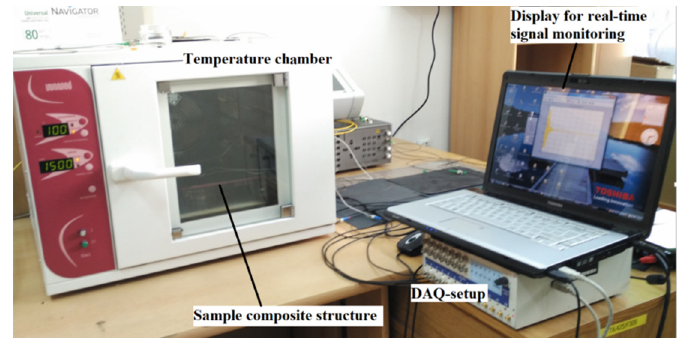
Figure 1. Experimental setup for the temperature-dependent analysis of debond effects on guided waves in the adhesively-bonded carbon-fibre composite structure (ACCS) .